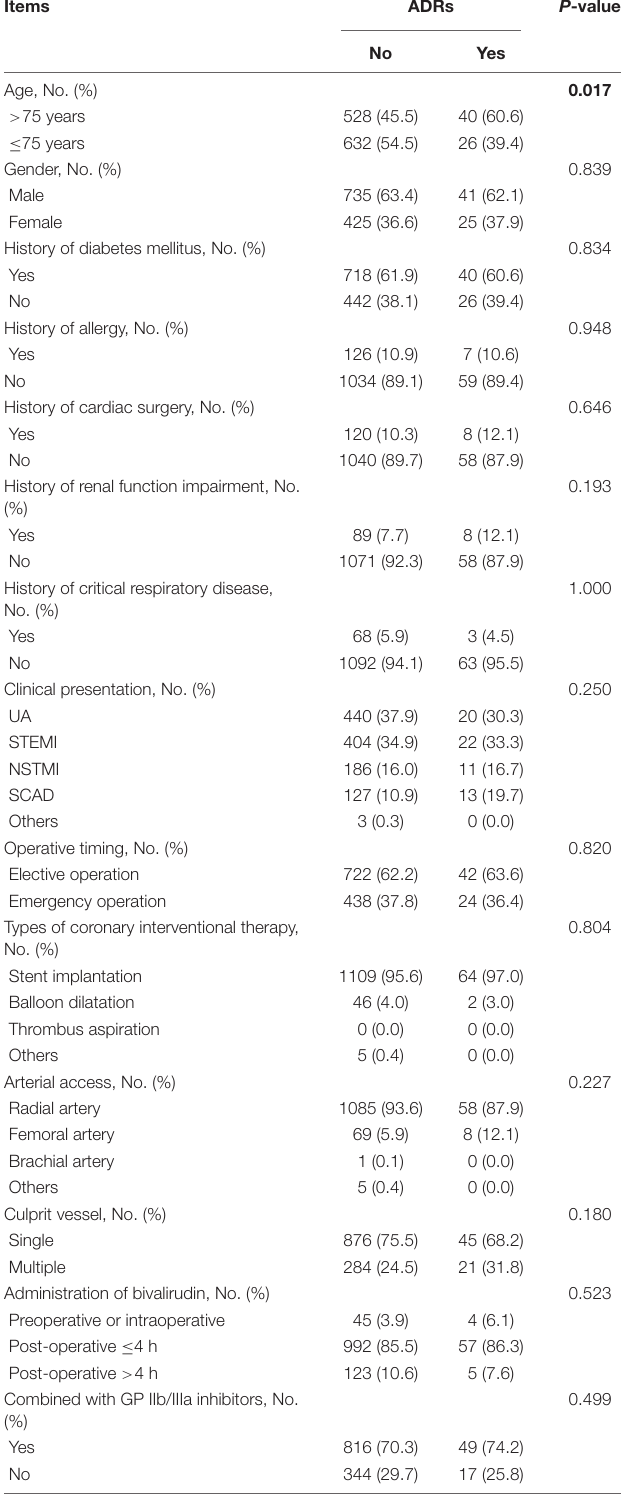
TABLE 2 | Correlations of characteristics with